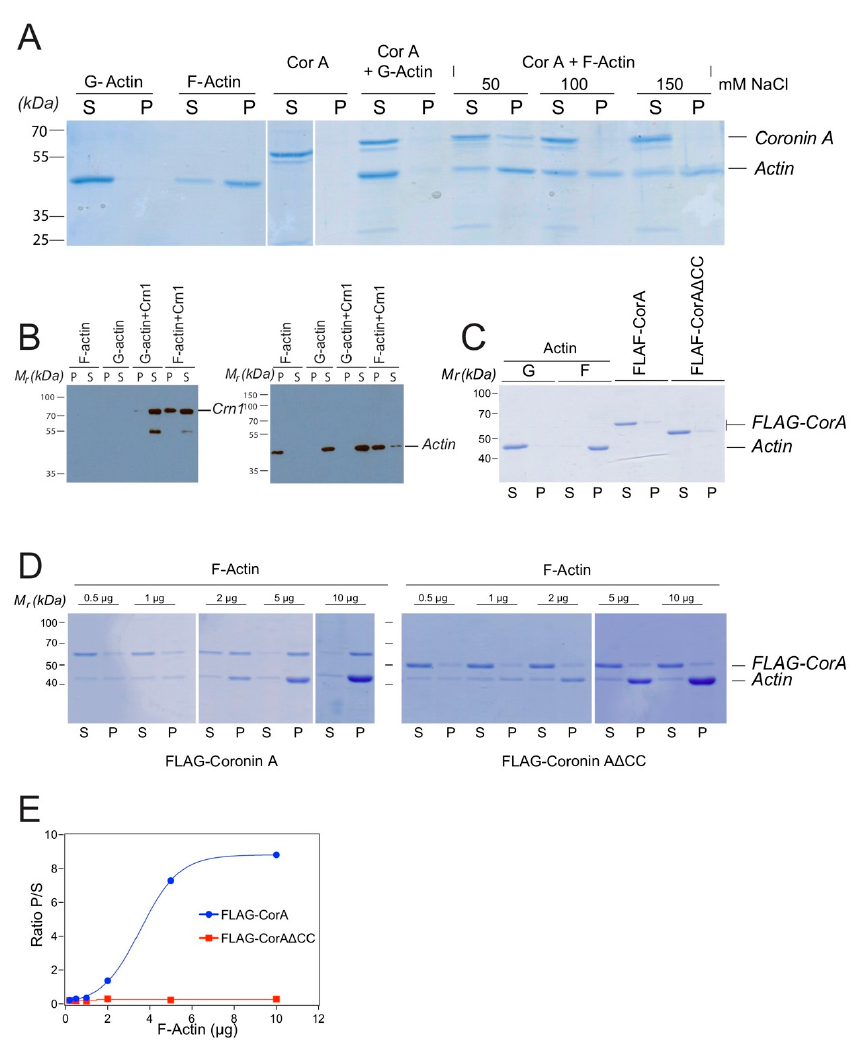
Figure 4. Coronin A-F-actin interaction with muscle F-actin in vitro. ( A ). Purified FLAG-CorA and / or equimolar amounts of rabbit muscle G-actin or F-actin was subjected to ultracentrifugation at 100,000× g , for 1h at 4 °C in the presence of rabbit muscle G-actin and F-actin and different NaCl concentrations. The supernatant was removed and the pellet resuspended in 2 × SDS-PAGE sample buffer. Samples were separated by SDS-PAGE and the gel stained using Coomassie blue. Lanes 1–4: controls; lanes 5–8: coronin A and G-actin; lanes 9–14: Sedimentation analysis was performed in the presence of the NaCl concentrations indicated. (B). Rabbit muscle F-actin or G-actin were incubated in the absence or presence of S. cerevisiae Crn1, incubated for 20 min at room temperature and the samples were then processed as described in the Materials and Methods. Pellets (P) and supernatants (S) were separated by SDS-PAGE and immunoblotted for Crn1 ( left panel ) or actin ( right panel ) as described above. The lower band most likely represents a degradation product of Crn1. (C) . Purified actin, FLAG-CorA or FLAG-CorA Δ CC were analyzed as in A, separated by SDS-PAGE and the gel stained using Coomassie blue. ( D ). Interaction of the indicated amounts of purified FLAG-CorA (top) or FLAG-CorA Δ CC (bottom) with rabbit muscle G- and F-actin was carried out as described in the Materials and Methods. Samples were separated by SDS-PAGE and the gel stained using Coomassie blue. ( E ). Plot of the ratio of rabbit muscle F-actin-bound (co-pelleting, P) to non-bound (S) for FLAG-CorA or FLAG-CorA ∆ CC determined from the mean grey values of the bands from the Coomassie blue stained gels. Curve fitting shows an apparent Kd of 8.9 µ g (CI 5–20 µ g). Shown are representative results from at least three (two in the case of panels D, E) independent